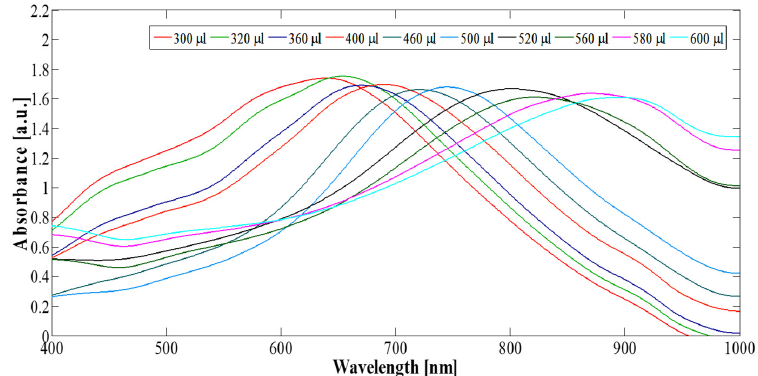
Figure 6. Adding increasing amounts of 1 mM HAuCl 4 to a fixed amount of 27 nm cubic silver template solution redshifts 𝜆 (cid:3040)(cid:3028)(cid:3051) from 600 to 900 nm. Increasing the amount of gold thins the HGN shell leading to the increase in 𝜆 (cid:3040)(cid:3028)(cid:3051) . Adapted from [45], published by Wiley, 2018.